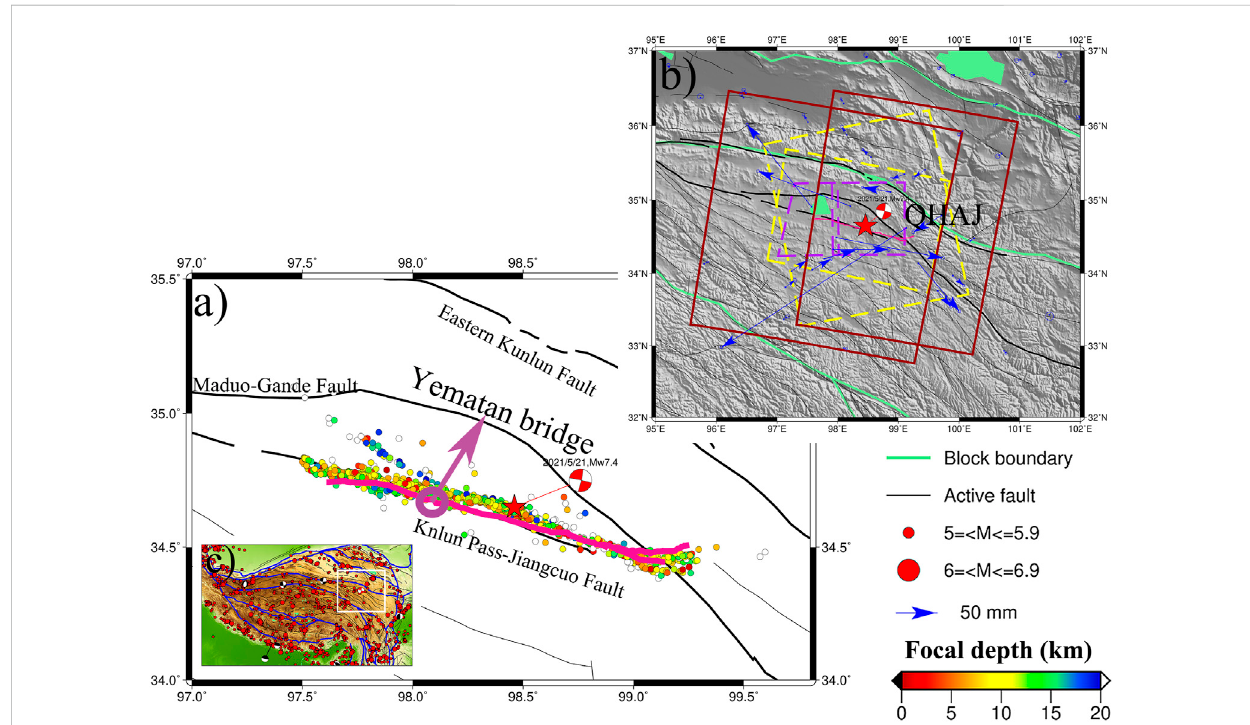
FIGURE 1 Tectonic setting of the 2021 Maduo earthquake. The red star denotes the epicenter location of the 2021 Maduo earthquake. Blue arrows in subplot (B) represent thecoseismichorizontal GPS displacements (Wang etal., 2022). The pinkline in (A) represents thesurfacerupture traces.In subplot (A) ,the black lines are active faults from Deng et al. (2003) and the colored points represent the focal depth from aftershocks of the Maduo earthquake (Wang etal.,2021).Theredboxesinsubplot (B) arethecoveragesofALOS-2SARdata.Theyellowdashedboxesrepresentthecoveragesofascendingand descending Sentinel-1 acquisitions. The purple dash boxes are denoted as coverages of Sentinel-2 data. The white box in subplot (C) is the region as shown in subplot (B)